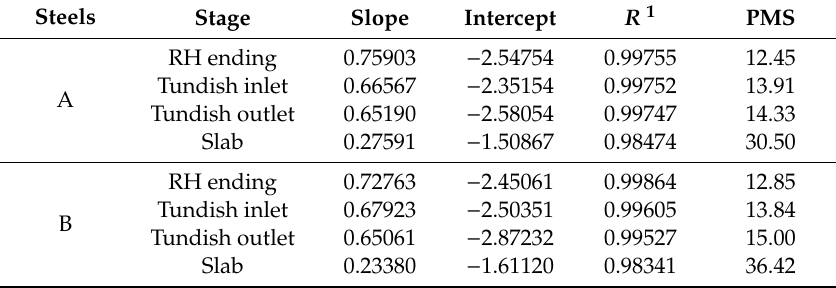
Table 2. Parameters of regression lines by SEV (Statistics of Extreme Values) at the di ff erent steelmaking stages for Steels A and